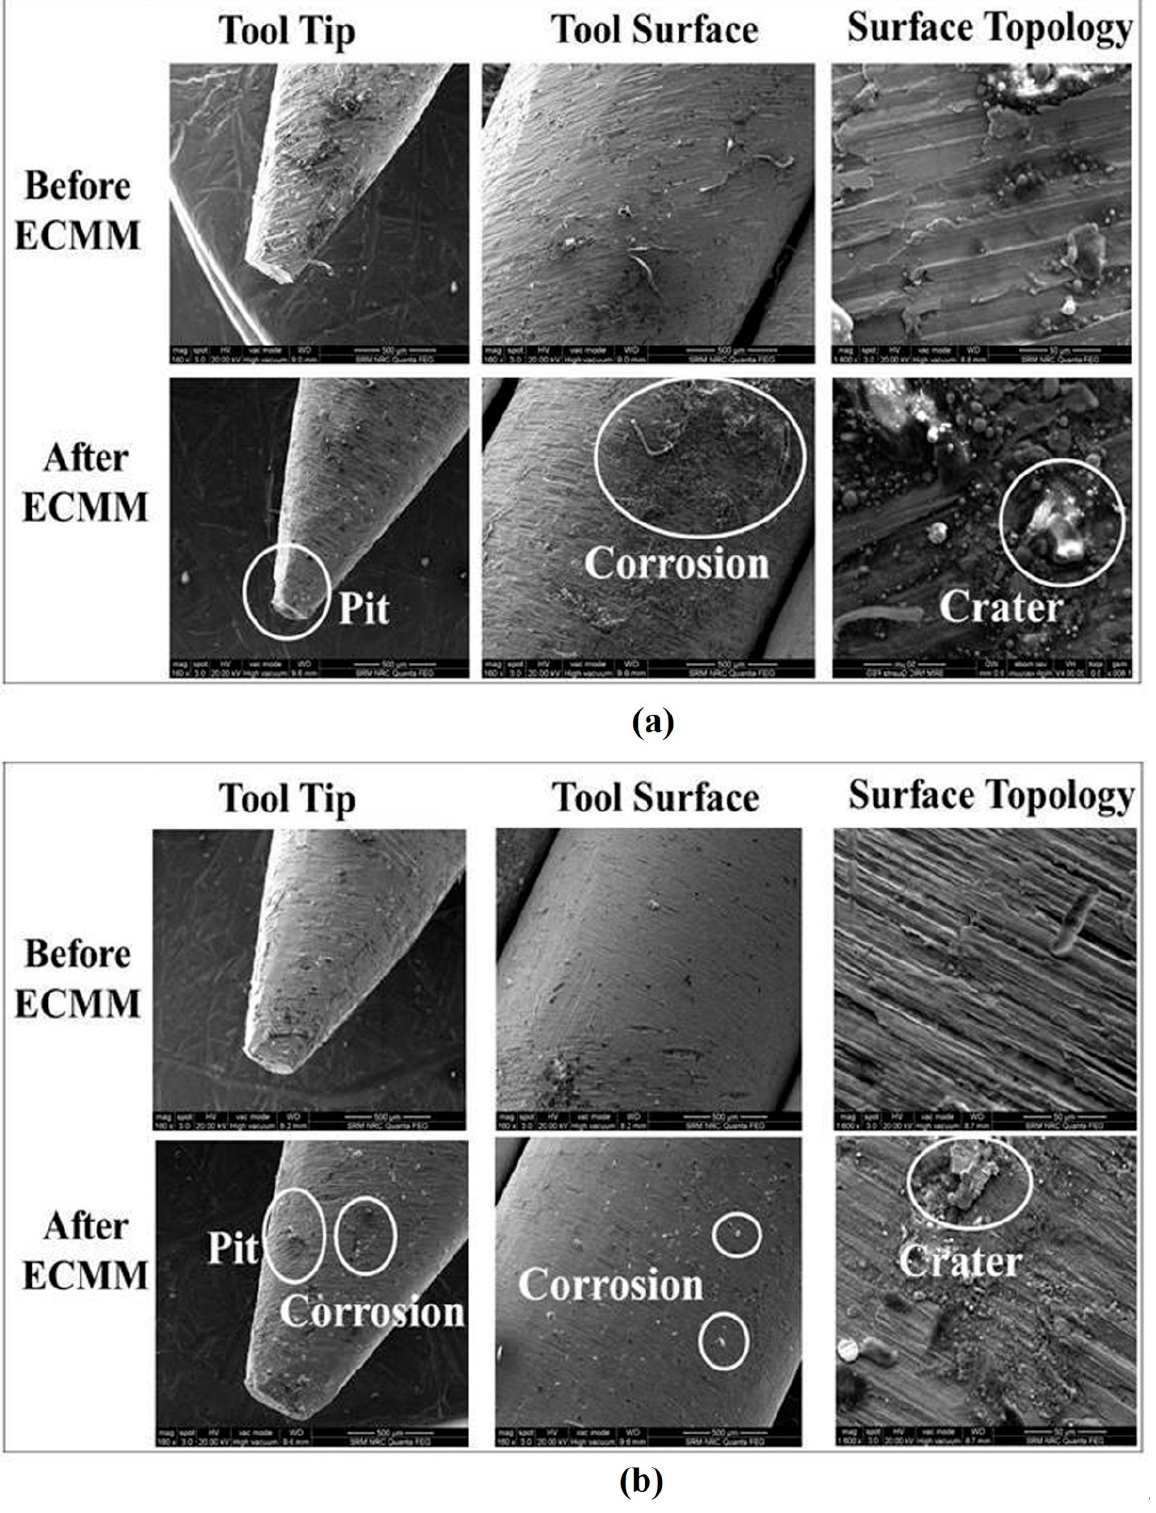
Figure 8. SEM analysis of machined specimens in ECMM ( a ) bare tool ( b ) AM tool.